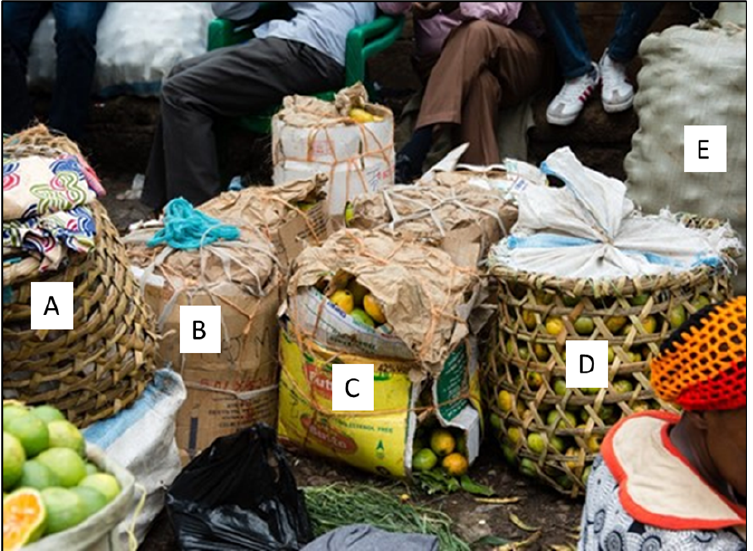
Figure 4. Different types of packaging used in a Uganda market: A and D show raffia basket, B and C cardboard and E plastic bag. (©Julien